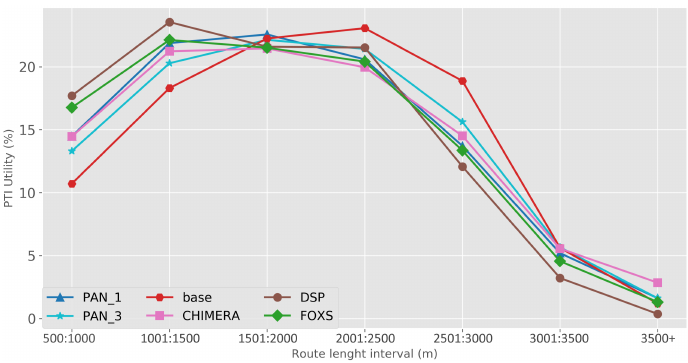
Figure 21. PTI Utility metric—Cologne